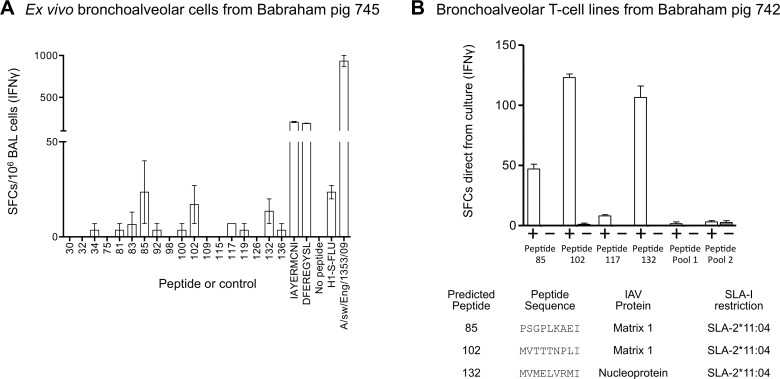
Verification of predicted influenza T-cell epitopes in bronchoalveolar from Babraham pigs infected with pandemic H1N1 swine influenza.Babraham pigs 742 and 745 were experimentally infected intranasally with H1N1 [A/sw/Eng/1353/09] and culled on day 14 post infection. Based on the binding motifs of SLA-1*14:02 and SLA-2*11:04 (Fig 8), predicted epitopes from matrix proteins 1 and 2, nucleoprotein, and polymerase basic proteins 1 and 2 (S6 Table) were tested as pooled peptides using BAL cells from pig 745 and IFNγ ELISpots (S7 Fig). Individual peptides highlighted from this process were then tested: (A) BAL cells from pig 745 were thawed and 200,000 used per well for IFNγ ELISPOT. 18 individual peptides (numbered on the x-axis) were used alongside our validated nucleoprotein epitopes, IAYERMCNI and DFEREGYSL. A no peptide and viral controls were included, and conditions performed in duplicate, scaled (X5) to 106 spot forming cells (SFCs) and with the mean displayed +SEM. Babraham kidney cells were used in every well (15,000 per well) to act as antigen presenting cells. (B) BAL cells from pig 742 were cultured in the presence of the peptides from (A) to create six T-cell lines (labelled on the x-axis). Peptides 85, 102, 117 and 132 were used individually as they gave relatively more SFCs for the ELISPOT in A. The remaining peptides were assembled in to two pools; pool 1 consisted of peptides 30, 32, 34, 75, 81, 83, 92; and pool 2 contained peptides 98, 100, 109, 115, 126, 136 (sequences in S6 Table). After two weeks, the lines were taken straight from culture for IFNγ ELISPOT and incubated with 10−5 M of the peptide(s) used to generate the line (+) or with no peptide (−). The actual number of SFCs is displayed as mean +SEM. The table shows the peptide sequence, the protein of origin and SLA-I restriction of the three epitopes that gave robust responses.